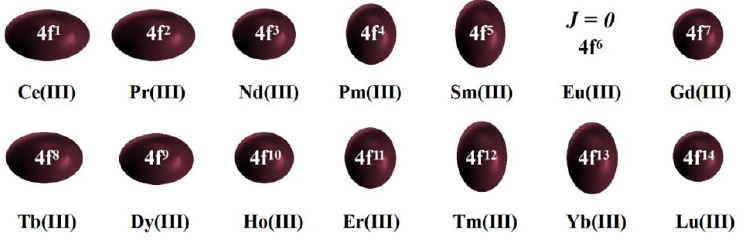
Figure 5. The shape of electron density in 4 f trivalent free ion (reproduced with permission from [47]).